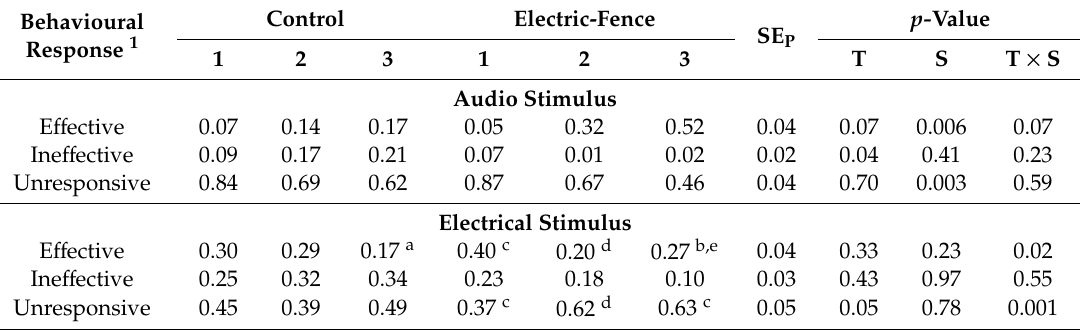
Table 2. The e ff ects of treatment (T: experience of electric fencing, ‘Electric-fence’; no experience of electric fencing ‘Control’), training session (S: 1, 2, or 3) and their interaction (T × S) on the proportion of e ff ective, ine ff ective and unresponsive behavioural reactions to the audio and electrical stimuli. Raw means and pooled standard error (SE P ) are presented (estimated marginal means are presented in Table S2). In the case of an interactive e ff ect, di ff erent superscript letters show where (within